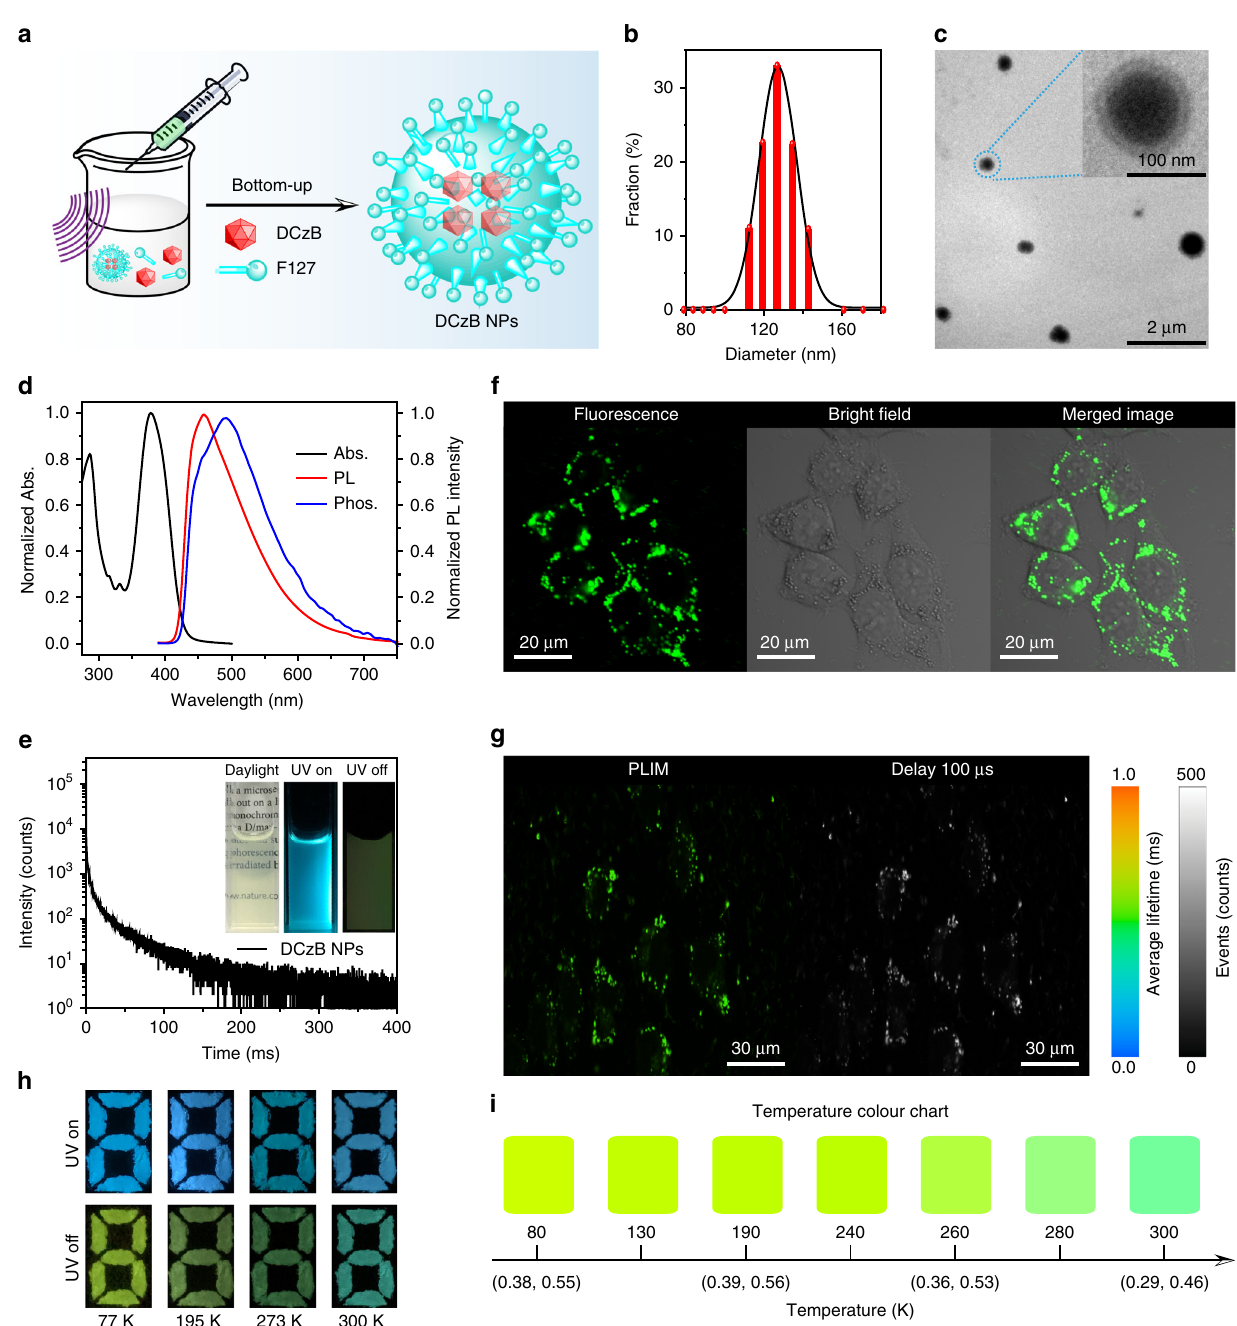
Fig. 5 Applications in afterglow cell imaging and visual temperature detection. a Bottom-up preparation of DCzB NPs using F127. b , c Particle size distribution revealed by dynamic light scattering ( b ) and transmission electron microscope images ( c ). d , e Absorption (black curve), steady-state PL (red curve), room-temperature phosphorescent spectra (blue curve, delay 5 ms) ( d ) and phosphorescence decay curve ( e ) of the DCzB NPs excited at 380 nm. The inset is the photographs taken under daylight and 365 nm light irradiation (UV on) and after the removal of the excitation (UV off). f , g Confocal fl uorescence images ( f ), PLIM and time-gated images (delayed 100 µ s) ( g ) of Hela cells incubated with DCzB nanoparticles at 37°C for 2 h. The collection range is 450 – 550 nm and the excitation wavelength is 405 nm. h Photographs of the pattern before (UV on) and after (UV off) the turning off of the 365 nm UV lamp at 77, 195, 273, and 300 K. i Temperature-dependent color chart with corresponding CIE coordinate showing the ability of DCzB crystals in visual sensing of temperatures. Source data are provided as a “ Source Data fi le ” excitation energies in the n-th singlet (S n ) and n-th triplet (T n ) states on the basis and was implemented to evaluate the electronic properties of the active QM of the optimized ground structure via spin-restricted formalism using B3LYP/6- molecule embedded in the aggregated crystal state, while the surrounding 31 G(d). SOC matrix elements between the singlet excited states and triplet molecules were de fi ned as rigid MM part to model the effect of solid-state excited states were calculated with quadratic response function methods using environment. The high layer for QM is calculated by the TD-DFT method of the Dalton program 1,36 . The SOC of DCzB was performed at the optimized B3LYP/6-31 G(d), and the low layer for MM is described by the universal force fi eld enhanced by Coulomb interactions which are in-line with the quantum geometry of the lowest triplet excited state (T 1 ) using B3LYP functional and cc- method. PVTZ basis set. The QM/MM model was built from the single-crystal structure